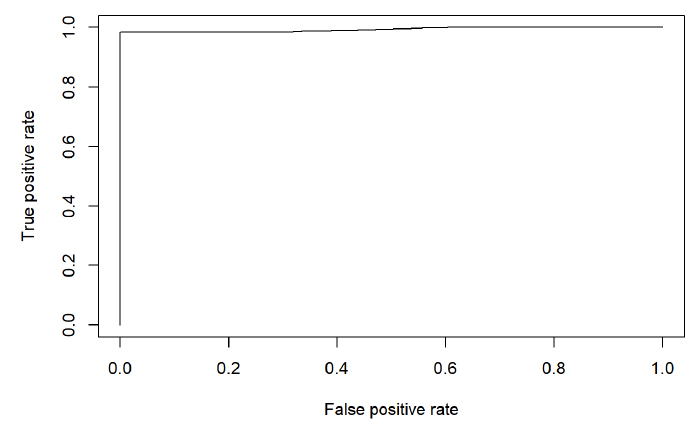
Figure 5. ROC 1 of the estimated model.